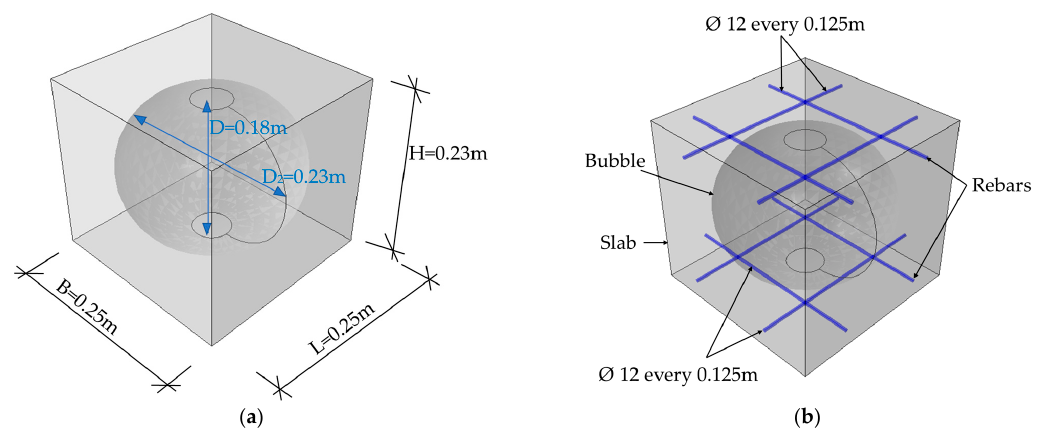
Figure 2. RVE-1—BD230: ( a ) geometry; ( b ) rebars.